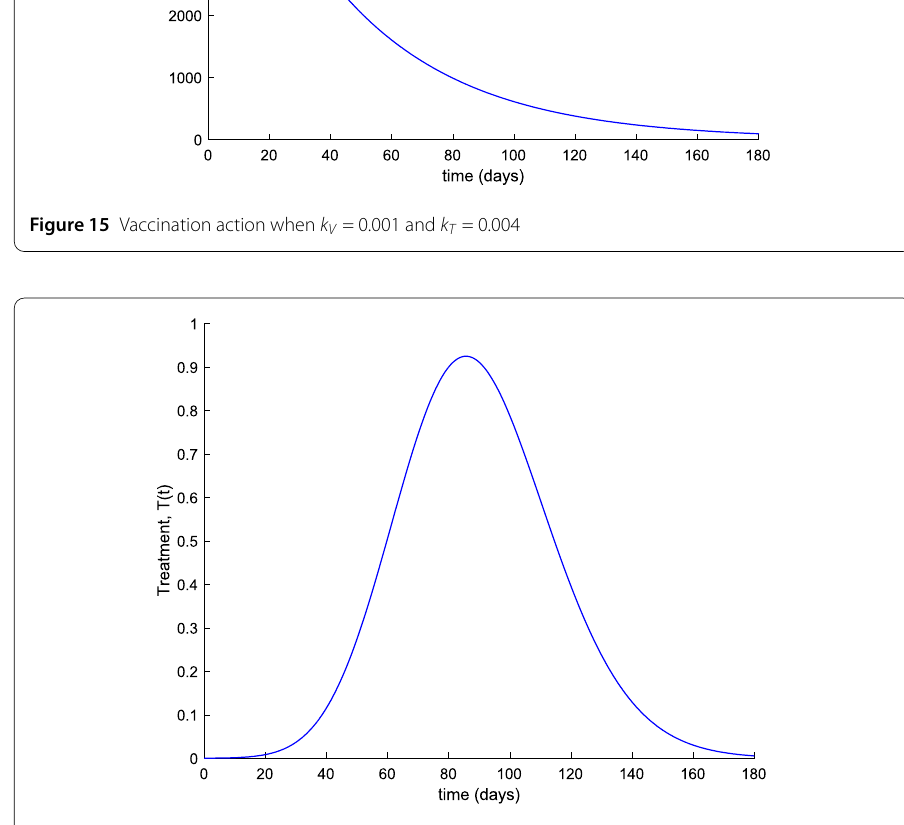
Figure 16 Treatment action when k T =